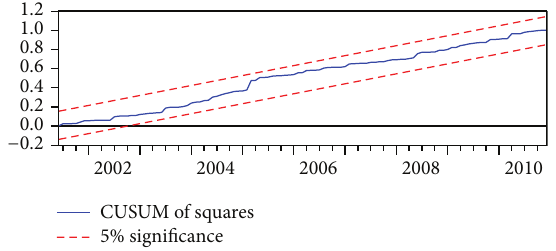
Figure 2: Plot of cumulative sum of squares of recursive residuals. The straight lines represent critical bounds at 5% significance